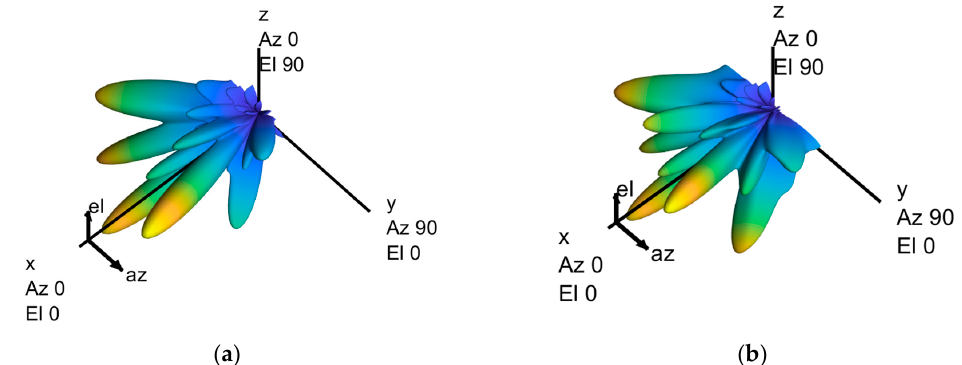
Figure 6. Beampattern of the backhaul link: ( a ) Proposed HBF, 4 RF chains; ( b ) fully-digital beamforming (optimal).